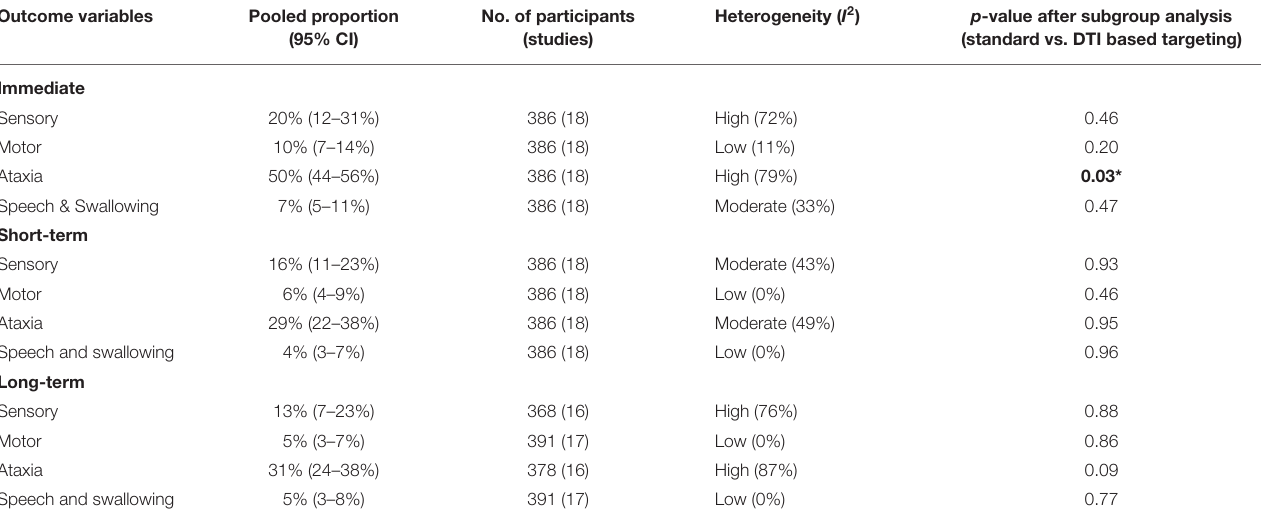
TABLE 6 | Summary of complications after meta-analysis. Outcome